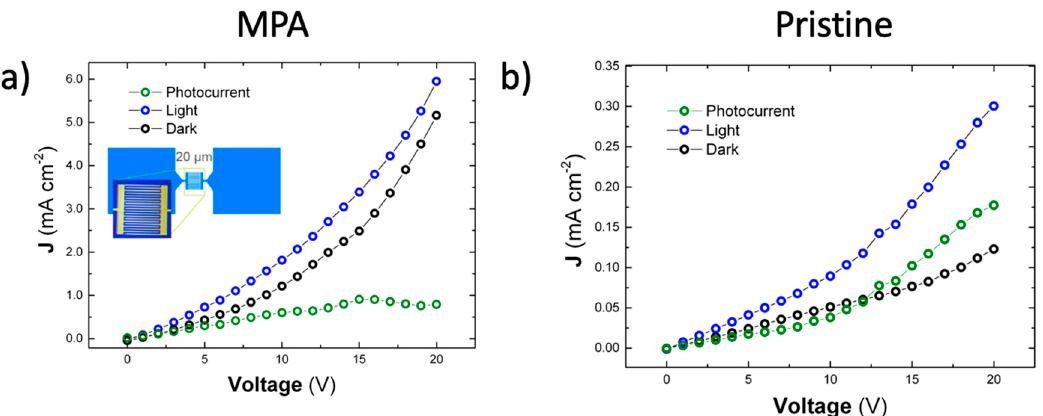
Figure 5. J–V characteristics of the device in dark conditions and under illumination with 25 mW cm -2 white light for ( a ) MPA-treated devices and ( b ) pristine devices. The photocurrent (difference between the light and the dark curves) is plotted in green color. The inset shows one test chip blueprint and optical microscopic image before the deposition of the CsPbBr 3 PNCs.